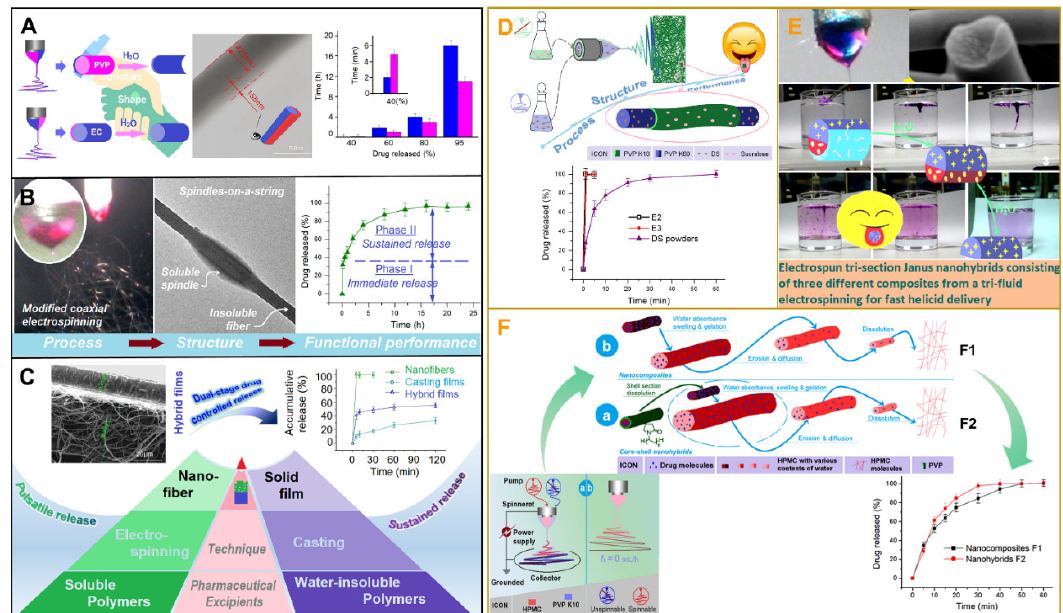
Figure 7. Performance triggered by transformation of electrospinning structures. ( A ) Improved coaxial electrospinning for biphasic drug release, reprint permission from ref. [21]. Copyright 2021, Elsevier; ( B ) String beaded nanofibers for biphasic drug release, reprint permission from Ref. [22]. Copyright 2021, Springernature; ( C ) The combination of cast film–nanofiber membrane for biphasic drug release [84]; ( D ) Improvement of coaxial (solvent circulation) to improve the solubility of the insoluble drug [23]; ( E ) Trisection Janus nanofibers for rapid release of insoluble herbal medicine, reprint permission from Ref. [24]. Copyright 2022, Springernature; ( F ) The core–shell nanohybrids for rapid release of the insoluble drug [87].